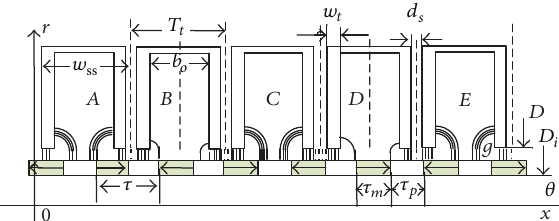
Figure 3: Flux paths due to the stator slot and mover